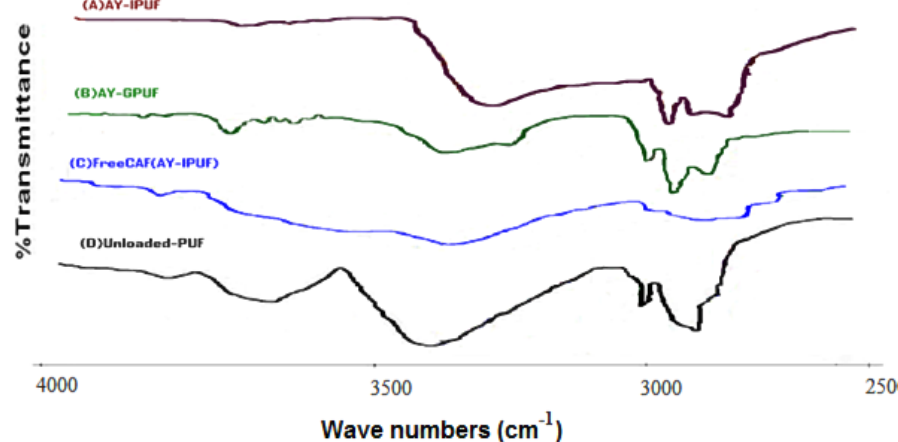
FIGURE 7 - IR spectra of various polyurethane foam phases: (A) AY-IPUF, (B) AY-GPUF, (C) CAF-free AY-IPUF, (D) unloaded- PUF.